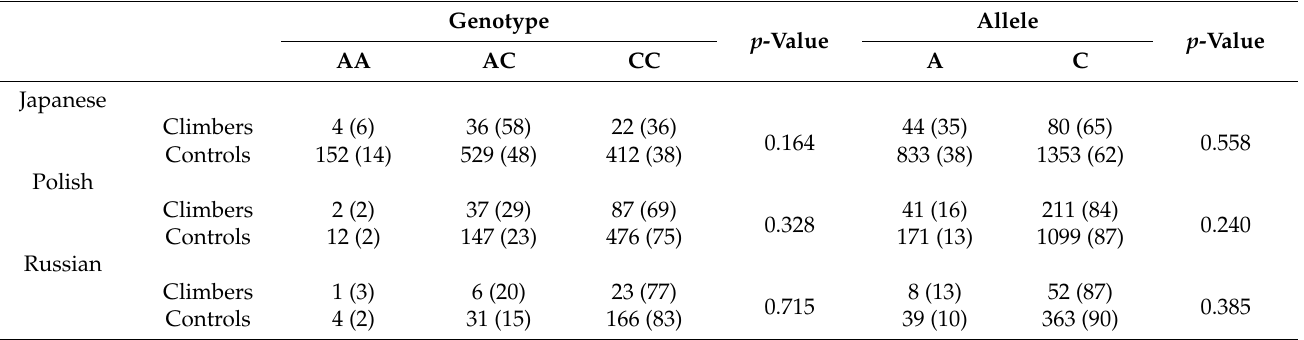
Table 1. Frequency of genotype and allele model of COL1A1 rs1107946 polymorphism in Japanese, Polish, and Russian climbers and